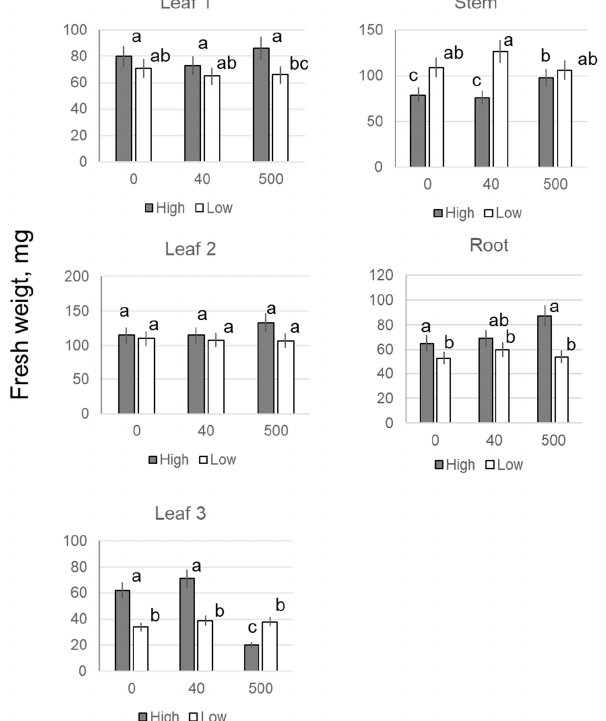
with 500 mg L –1 NP. Changes in dry weight were broadly in line with changes in fresh weight (FW). In 23-day-old plants, beneficial effects of NPs on biomass allocation were observed for 40, 200, and 500 mg L − 1 treatments, with the biomass of the fourth leaf being 7–10 times higher than the control (Table 1). The above effects were specific for iron nano- particles and were not observed when Fe chelate was used as a mock control (Supplemen-